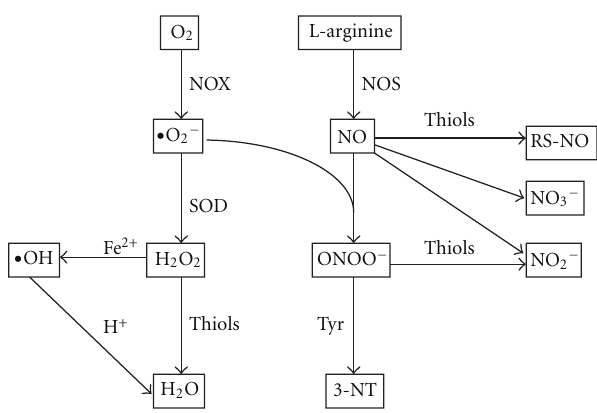
Figure 3: Reactive oxygen and nitrogen species and redox relevant molecules in EBC. Exhaled nitric oxide (NO) is derived from L-arginine by enzyme nitric oxide synthase (NOS). NO can combine with superoxide ( • O 2 − ) to form peroxynitrite (ONOO − ). ONOO − induces nitrosation of tyrosine (Tyr) residues and forms 3-nitrotyrosine (3-NT). NO can also react with thiols to form S-nitroso thiols (RS-NO). The end-products of NO are nitrite (NO 2 − ) or nitrate (NO 3 − ). • O 2 − is one of major reactive oxygen species generated from NADPH oxidase (NOX) or mitochondrial electron transfer chain. • O 2 − is converted to hydrogen peroxide (H 2 O 2 ) by superoxide dismutases (SOD). H 2 O 2 can be converted to the highly reactive hydroxyl radical ( • OH), which is catalyzed by Fe 2+ (Fenton reaction). H 2 O 2 can be removed by thiol-specific antioxidant enzymes to form